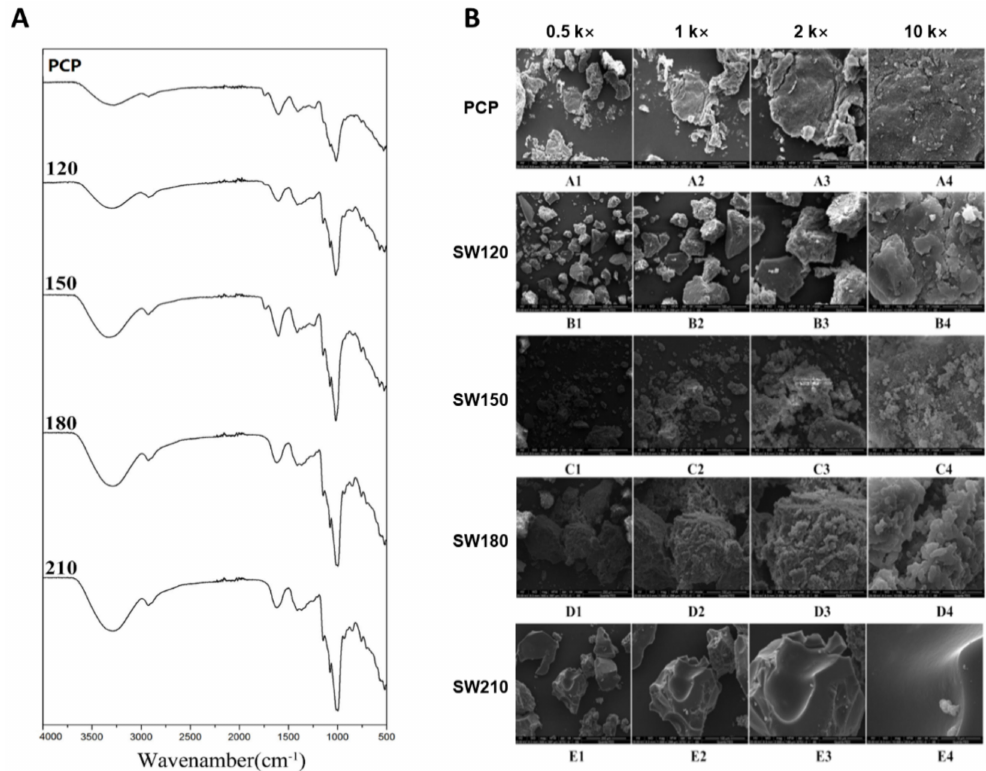
Figure 4. FTIR spectra ( A ) and scanning electron microphotograph (SEM) ( B ) of pumpkin polysaccharides treated with different subcritical water (SCW)